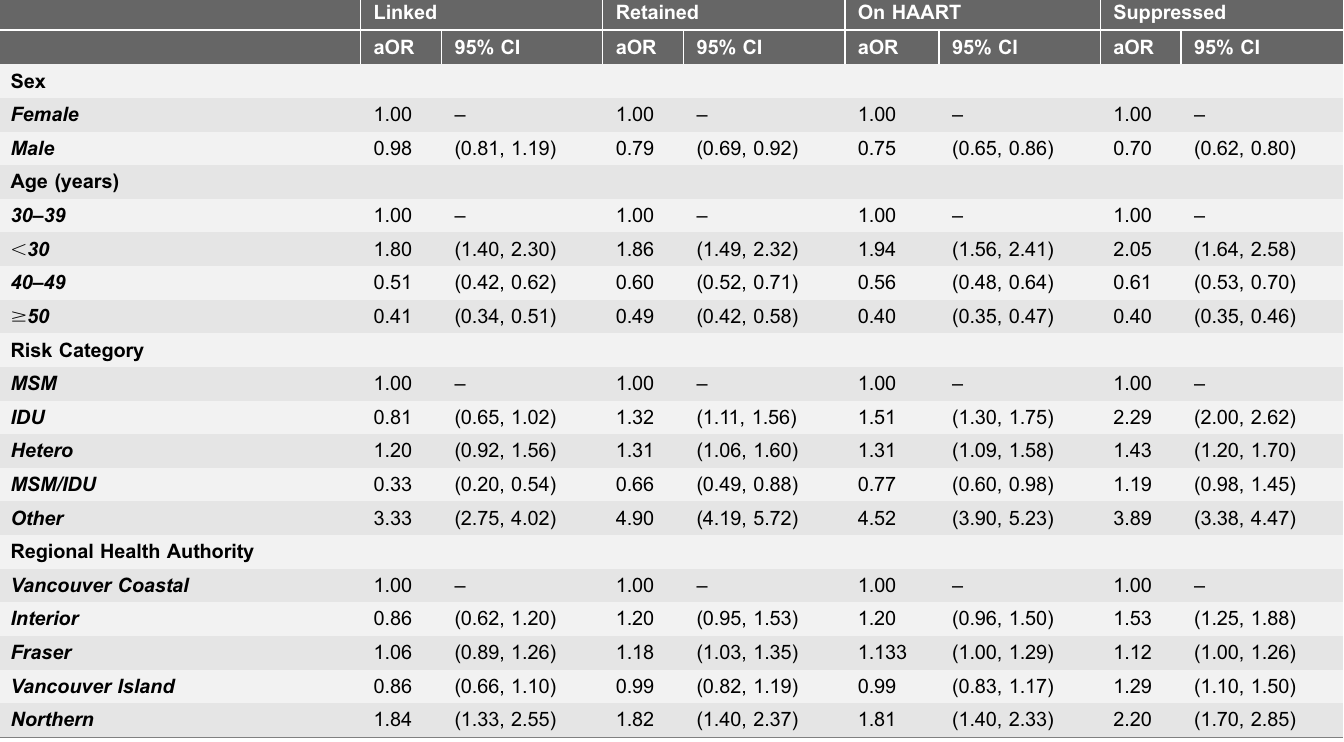
Table 2. Adjusted odds ratios predicting attrition between stages of the 2011 HIV cascade of care based on sex, age, transmission risk category and regional health authority for British Columbia residents diagnosed with HIV before 2011.